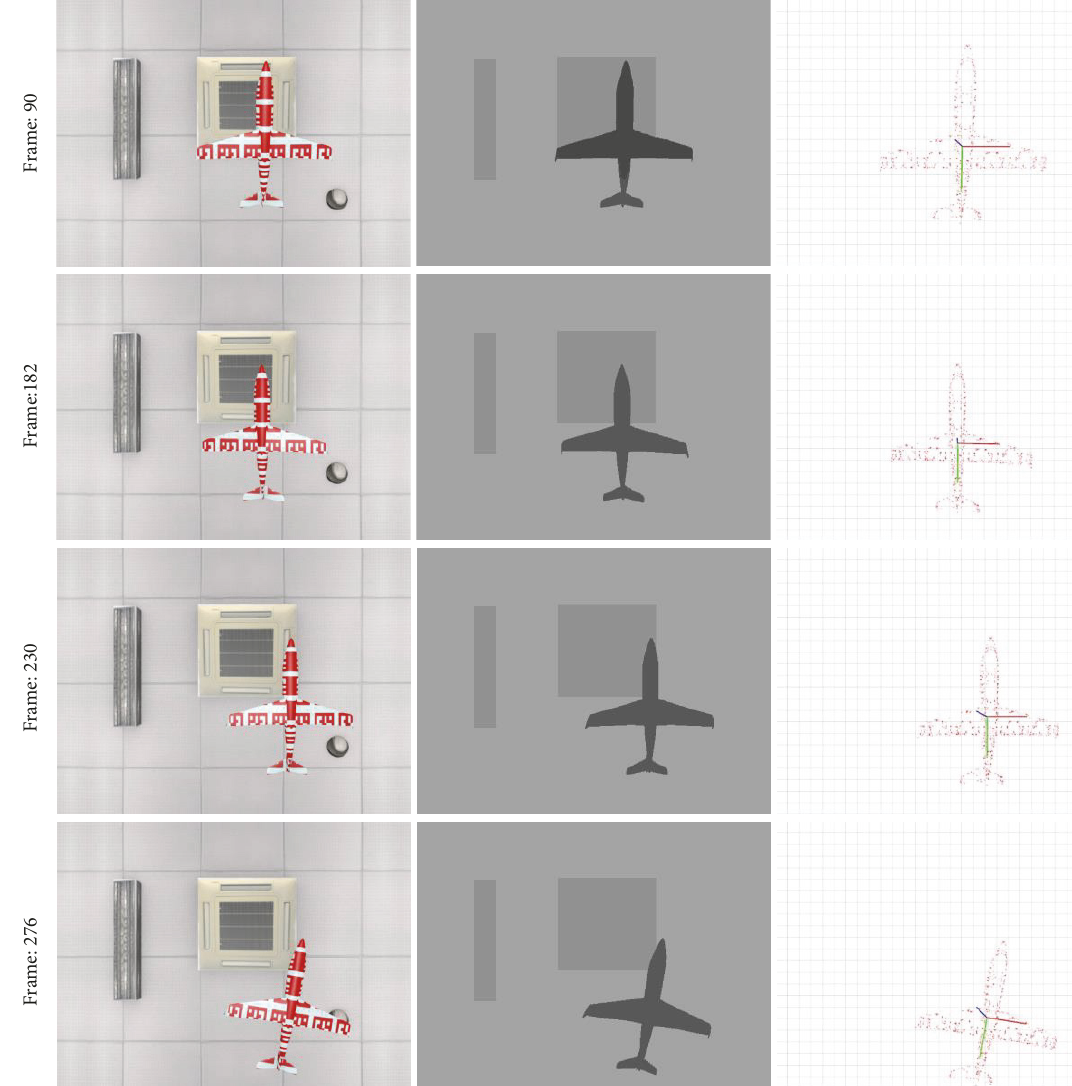
Figure 5: The synthetic RGB-D input and the estimated point cloud result of our system.